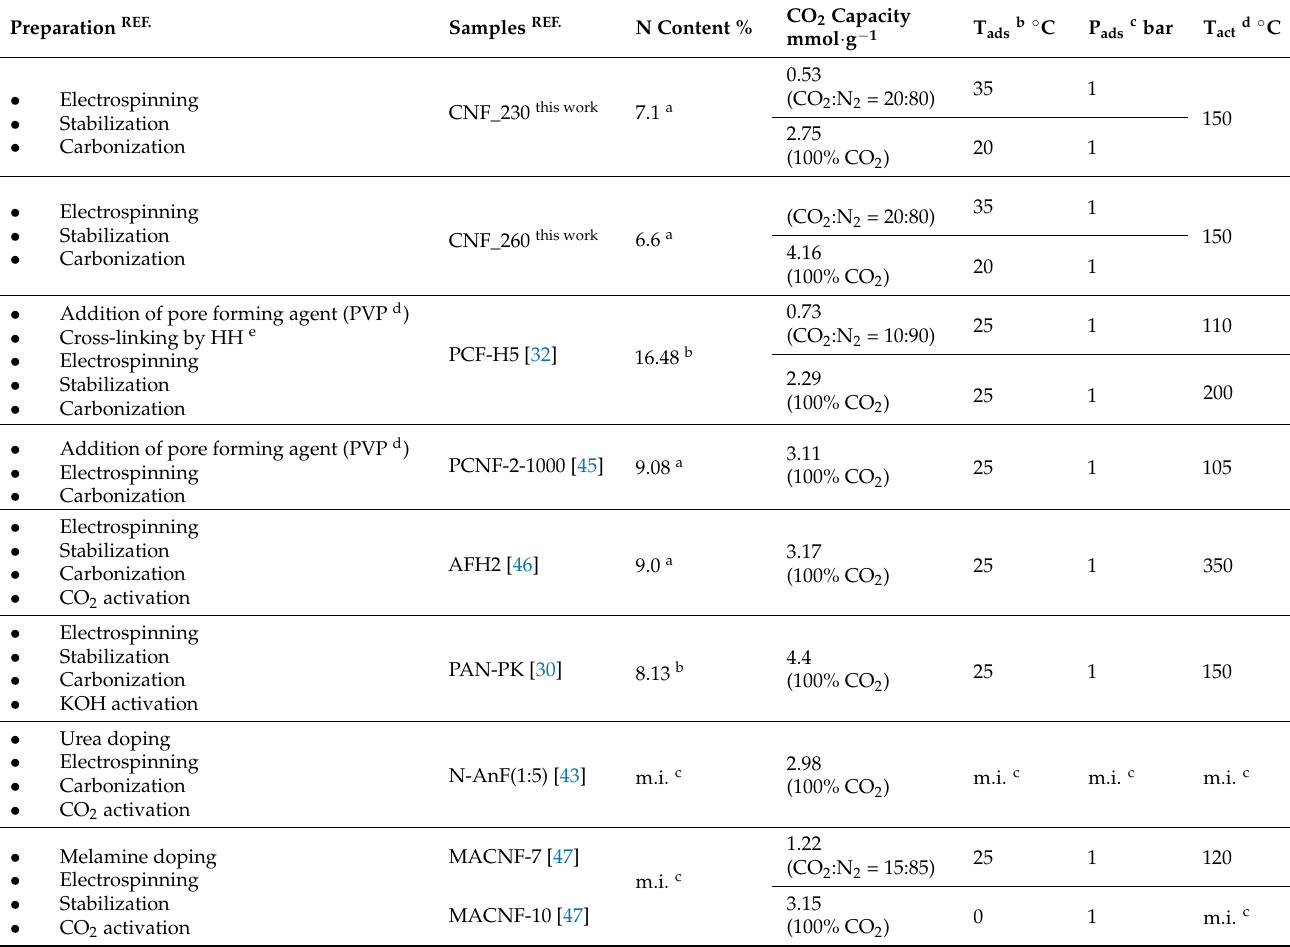
Table 2. Adsorption performances at different conditions, preparation steps, and nitrogen content of literature samples compared to this work. Preparation REF. Samples